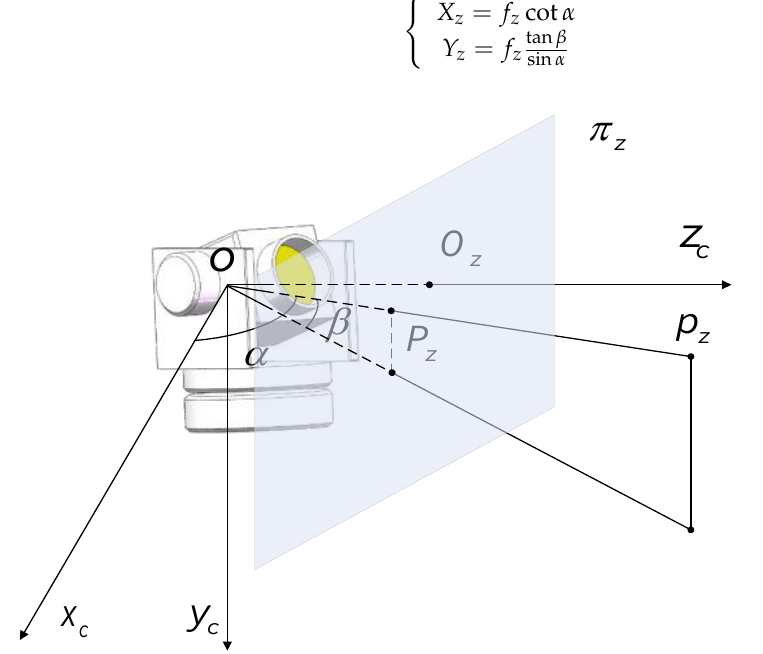
Figure 4. Virtual camera model on π z . A 2D rectangular coordinate system O x − YZ is established on the plane π x . Analo- gously, azimuth α and pitch β are transferred to the virtual image coordinate by the virtual image plane π x :